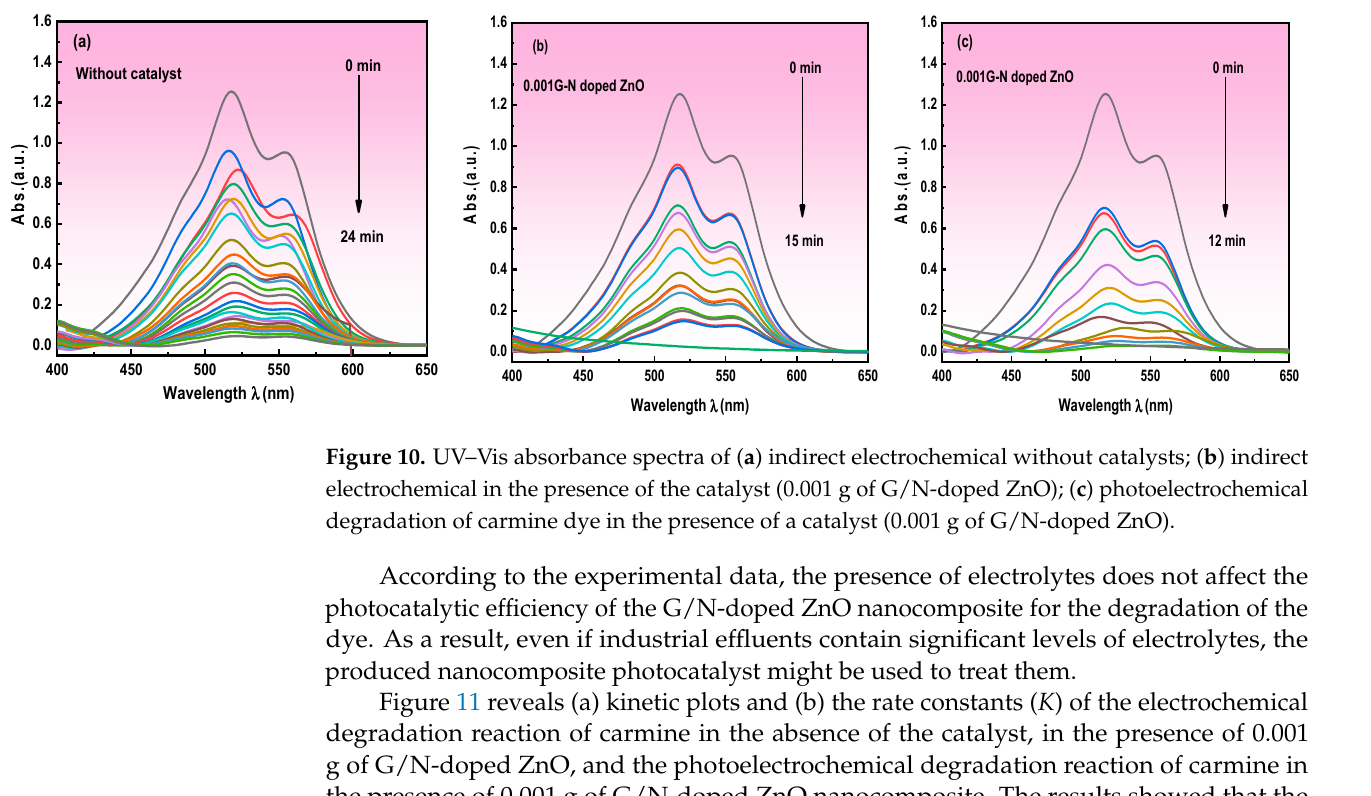
the absence of the catalyst has a lower value of the rate constant (0.1198 min − 1 absence of the catalyst has a lower value of the rate constant (0.1198 min − 1 ).